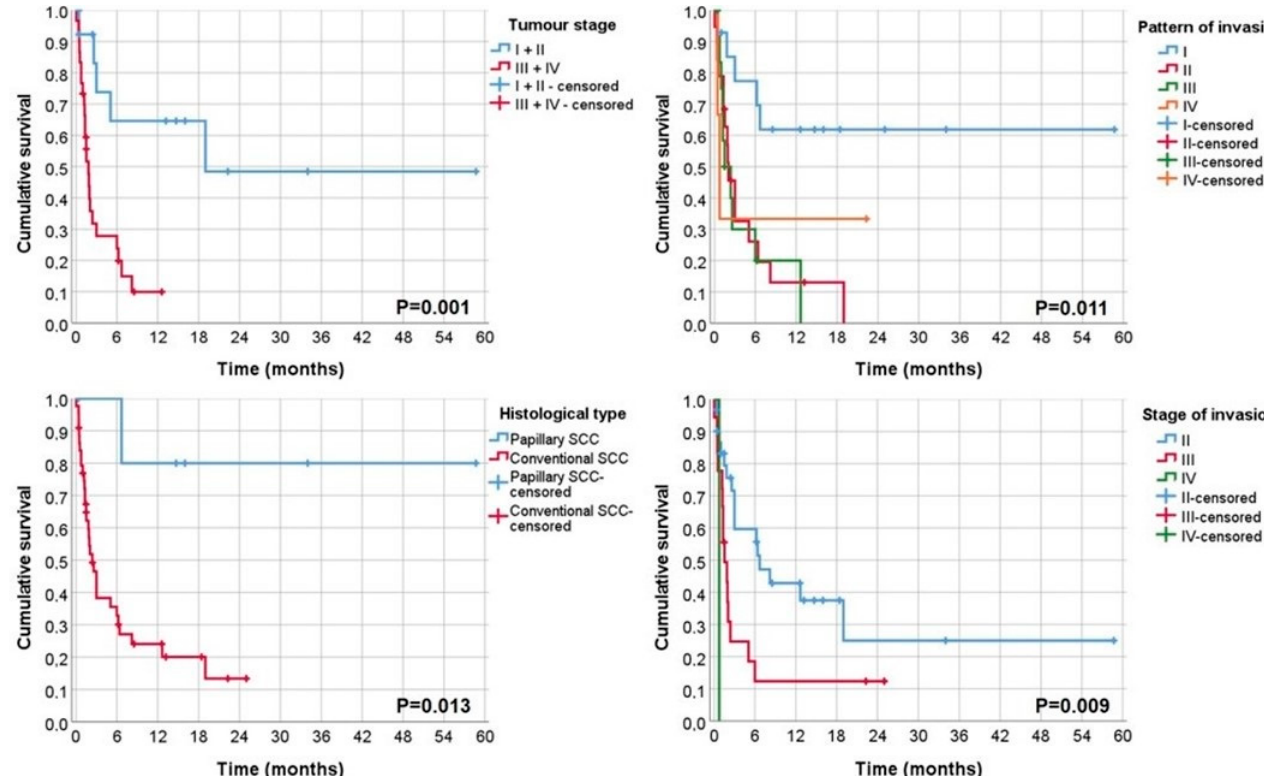
Figure 3. Kaplan Meier curve of CCS for tumour stage, pattern of invasion, histological type and stage of invasion.